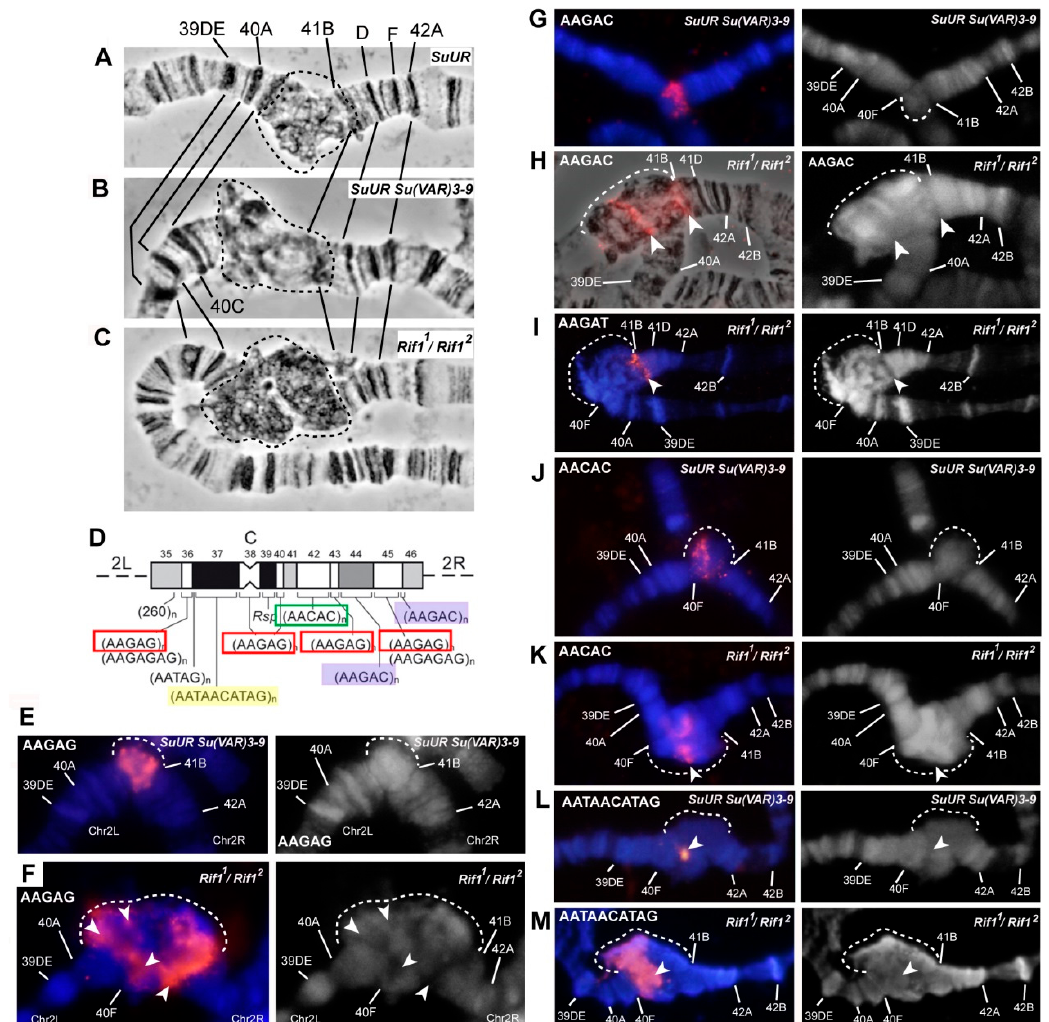
Figure 5. E ff ect of Rif1 on the heterochromatin of chromosome 2. ( A – C ) Morphology of the pericentromeric regions of chromosome 2 in mutants SuUR ES ( A ), SuUR ES Su(var)3-9 06 ( B ) and Rif1 1 / Rif2 2 ; ( C ); dotted line indicates the zone of β -heterochromatin morphology. ( D ) A map of the mitotic heterochromatin of chromosome 2 (adapted from [35]). Colors denote the satellite types used for in situ hybridization; ( E – M ) in situ hybridization of satellite DNA probes with the polytene chromosome 2 of mutants SuUR ES Su(var)3-9 06 ( E , G , J , L ) and Rif1 1 / Rif2 2 ( F , H , I , K , M ). Probes: AAGAG ( E , F ), AAGAC ( G , H ), AAGAT ( H ), AACAC ( J , K ) and Prodsat (AATAACATAG) ( L , M ). White dashed lines indicate the β -heterochromatin of chromosome 2 (the 40F–41B